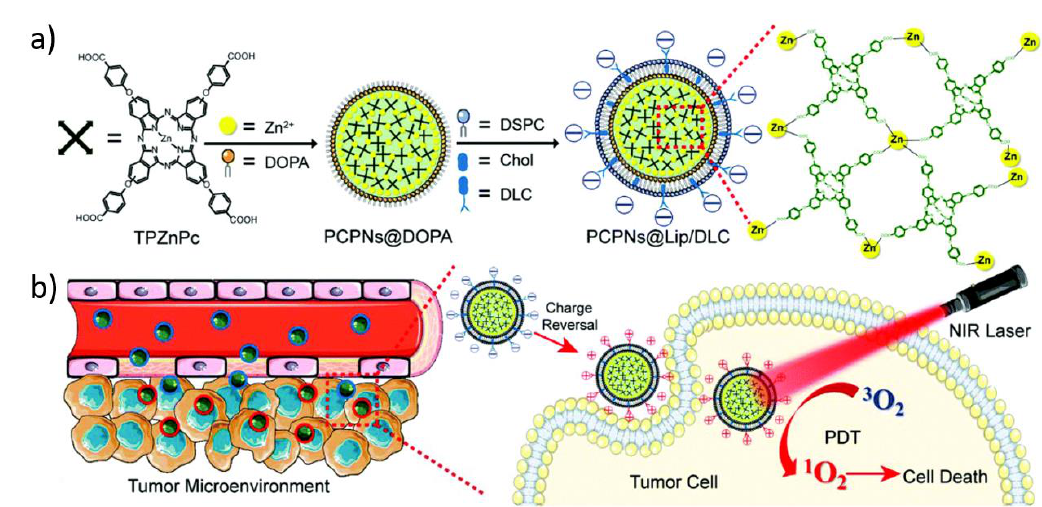
Figure 5. ( a ) Schematic representation of the synthesis and application of photodynamic therapy (PDT) active nanostructured coordination polymers (NCPs). ( a ) Preparation of the nanoparticles, and ( b ) accumulation in the tumor after intravenous administration, which is followed by its charge-reversal ability to improve the selective uptake and effective PDT in tumor cells after laser irradiation. The figure is reproduced from Reference [90] with the permission from American Chemical Society.